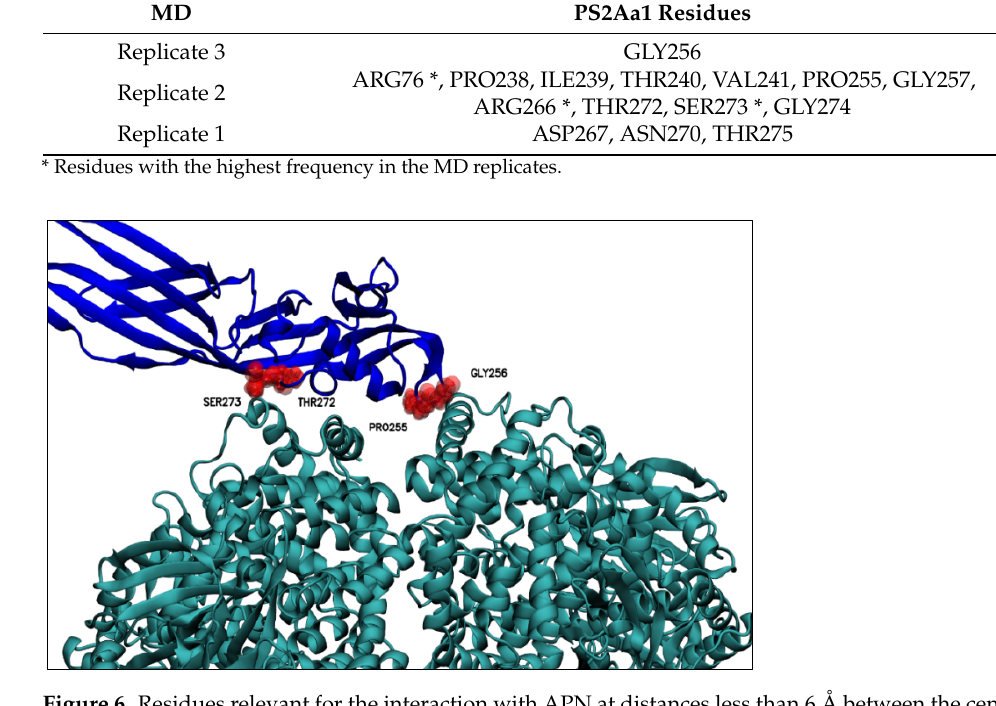
Figure 6. Residues relevant for the interaction with APN at distances less than 6 Å between the center of mass of the relevant PS2Aa1 residues and the nearest APN residue. Above, PS2Aa1 and APN are colored blue and teal, respectively.